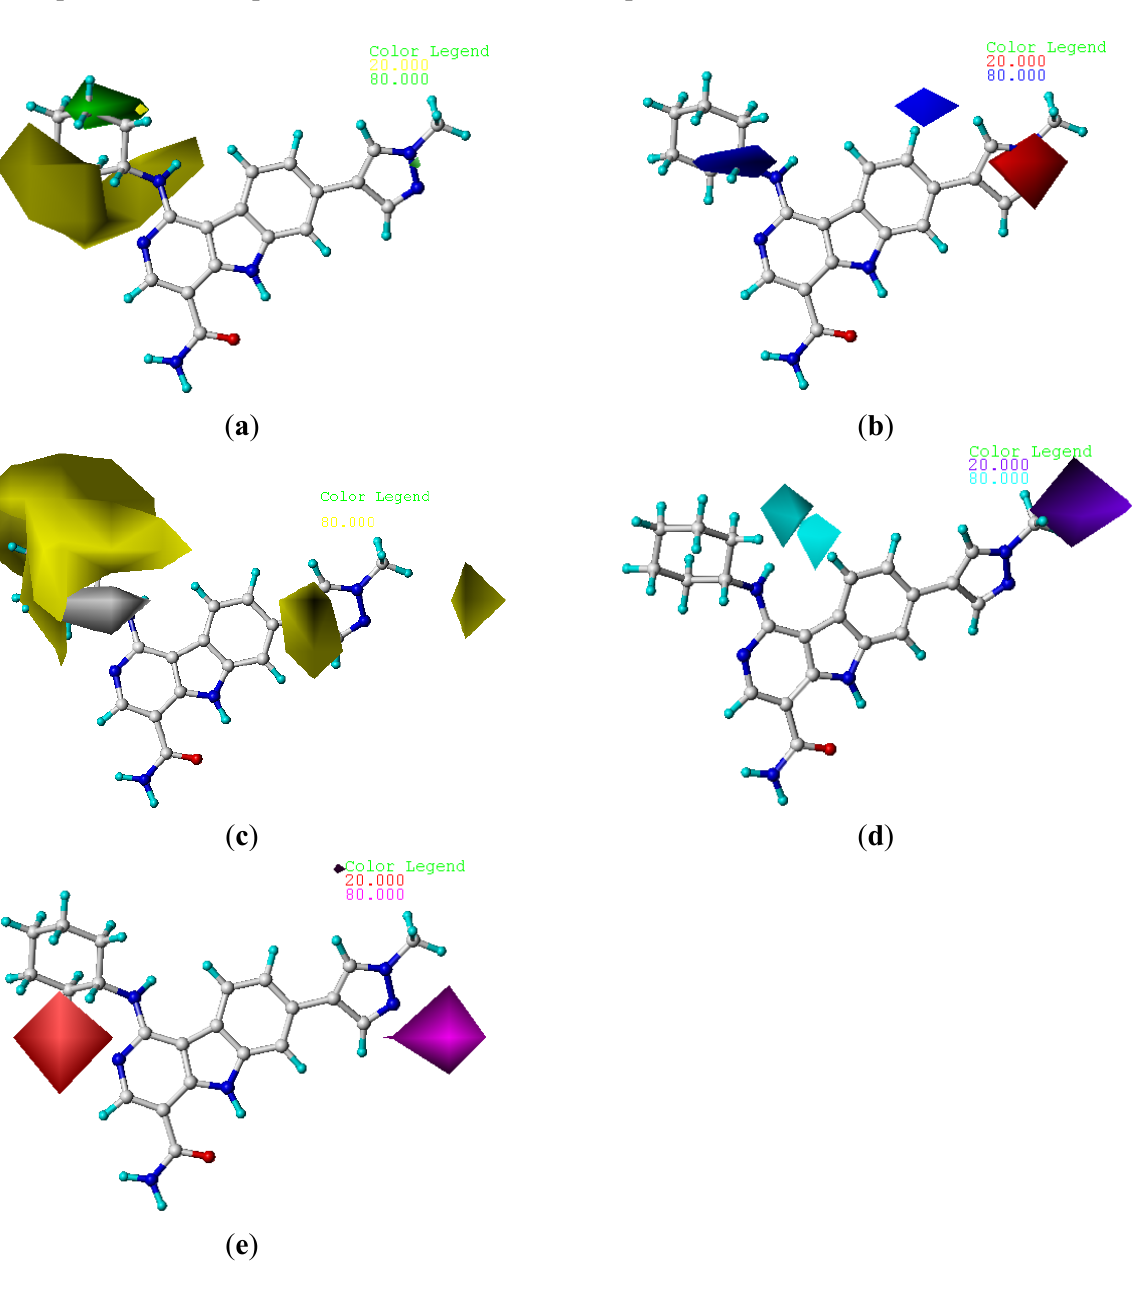
Figure 3. StDev*Coeff contour maps. ( a ) Favorable (green) and unfavorable (yellow) steric fields; ( b ) Electropositive (blue) and electronegative (red) fields; ( c ) Favorable (yellow) and unfavorable (gray) hydrophobic fields; ( d ) Favorable (cyan) and unfavorable (purple) hydrogen bond donor fields; ( e ) Favorable (magenta) and unfavorable (red) hydrogen bond acceptor fields. Compound 22 was overlaid in each